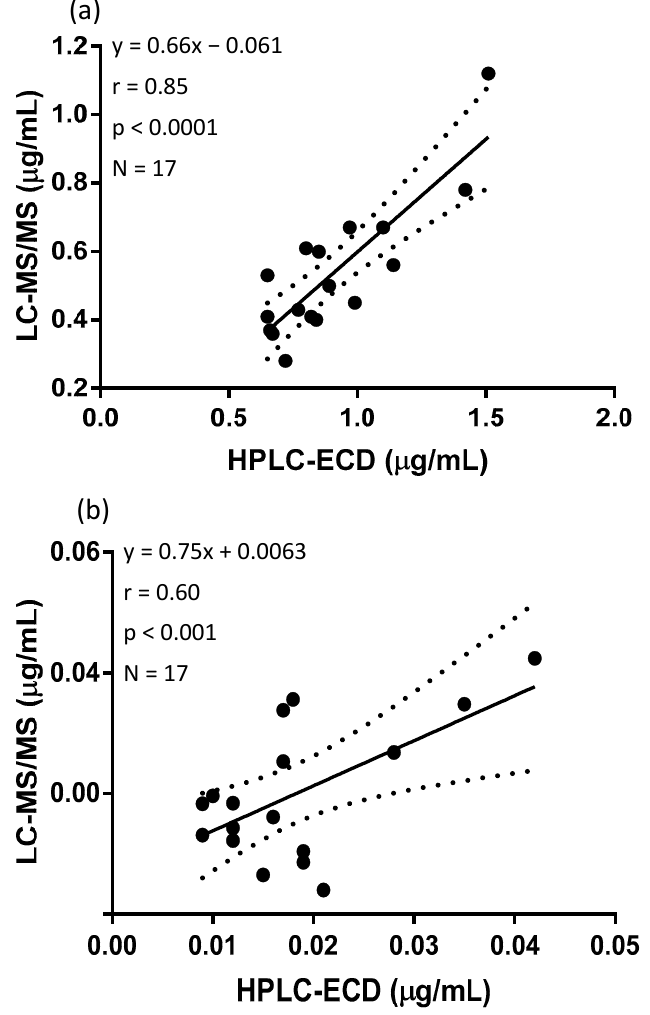
Figure 5. ( a ) Correlation of CoQ 10 H 2 and ( b ) correlation of CoQ 10 in canine plasma analyzed by HPLC-ECD and LC-MS/MS. The dotted line corresponds to 95% confidence limits.